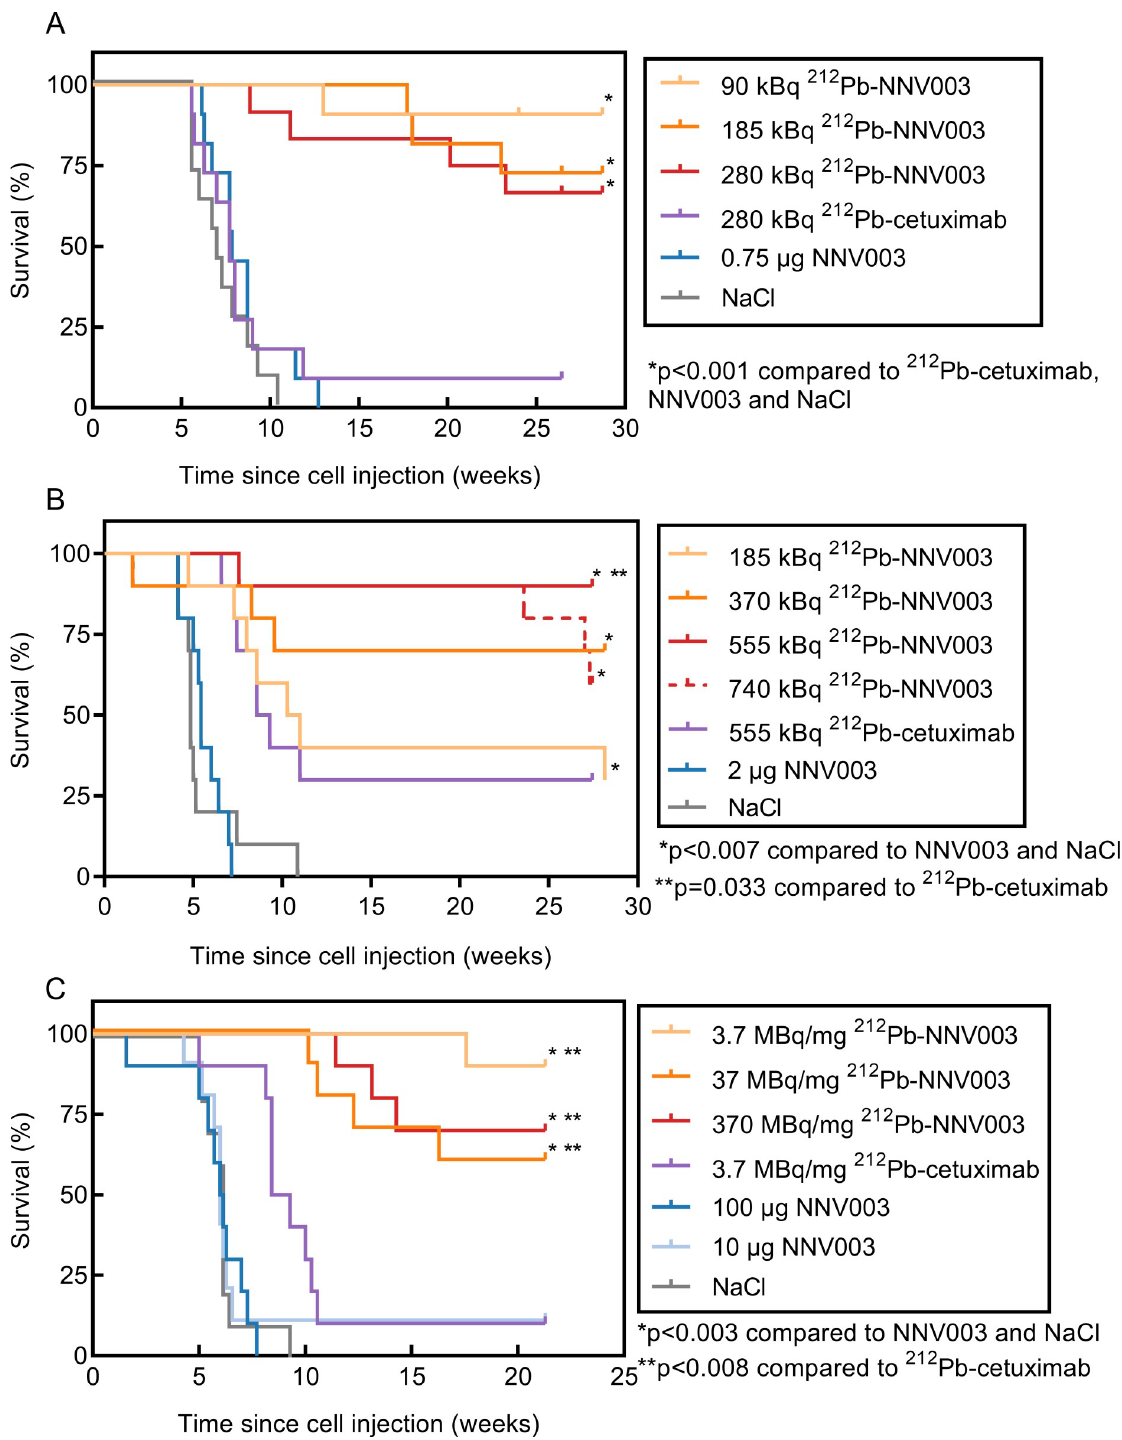
Fig 5. Anti-tumour effect of 212 Pb-NNV003. Survival of (A) CB17 SCID mice (n = 11 or 12) i.v. injected with Daudi cells and of (B) R2G2 mice (n = 10) i.v. injected with MEC-2 cells two days prior to treatment with 212 Pb-NNV003, 212 Pb-cetuximab, NNV003 or NaCl. (C) Survival of R2G2 mice (n = 10) i.v. injected with MEC-2 cells two days prior to treatment with 370 kBq 212 Pb-NNV003 with increasing SAs, 212 Pb-cetuximab, NNV003 or NaCl. Mice were censored at the end of the study.